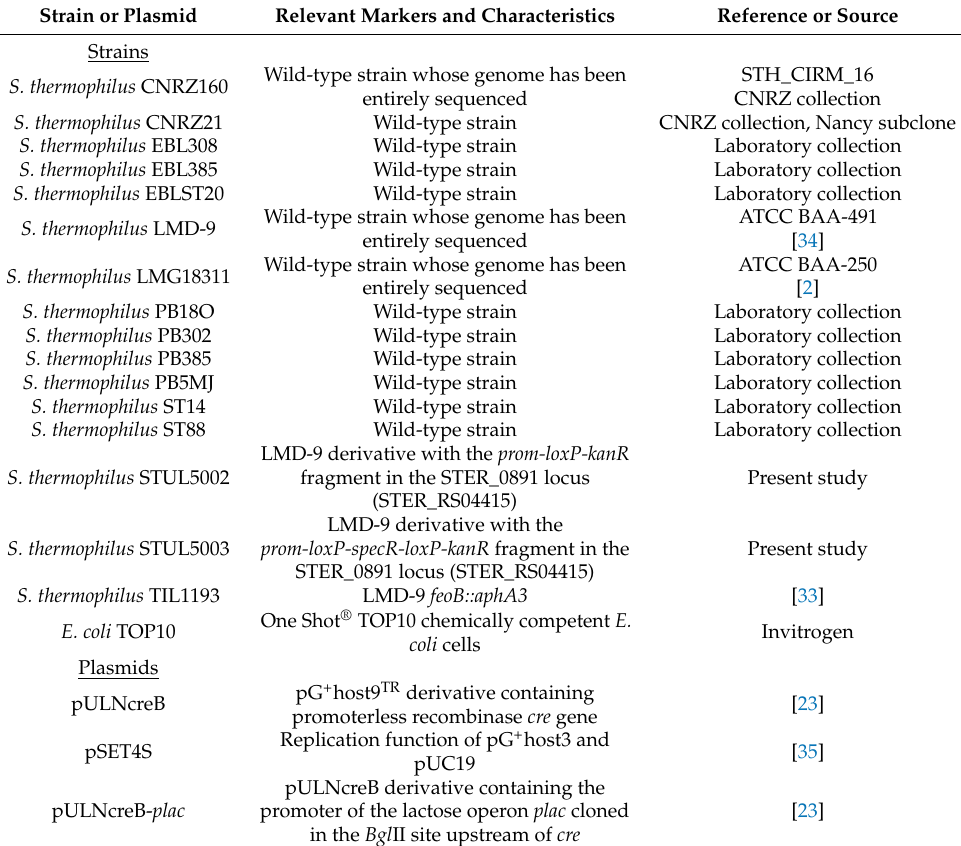
Table 1. Bacterial strains and plasmids used in the present